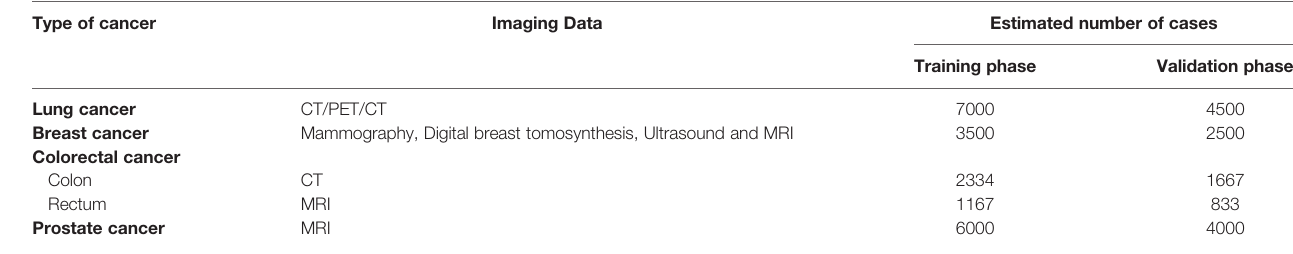
TABLE 3 | Types of datasets to be accessible from the CHAIMELEON repository. Type of